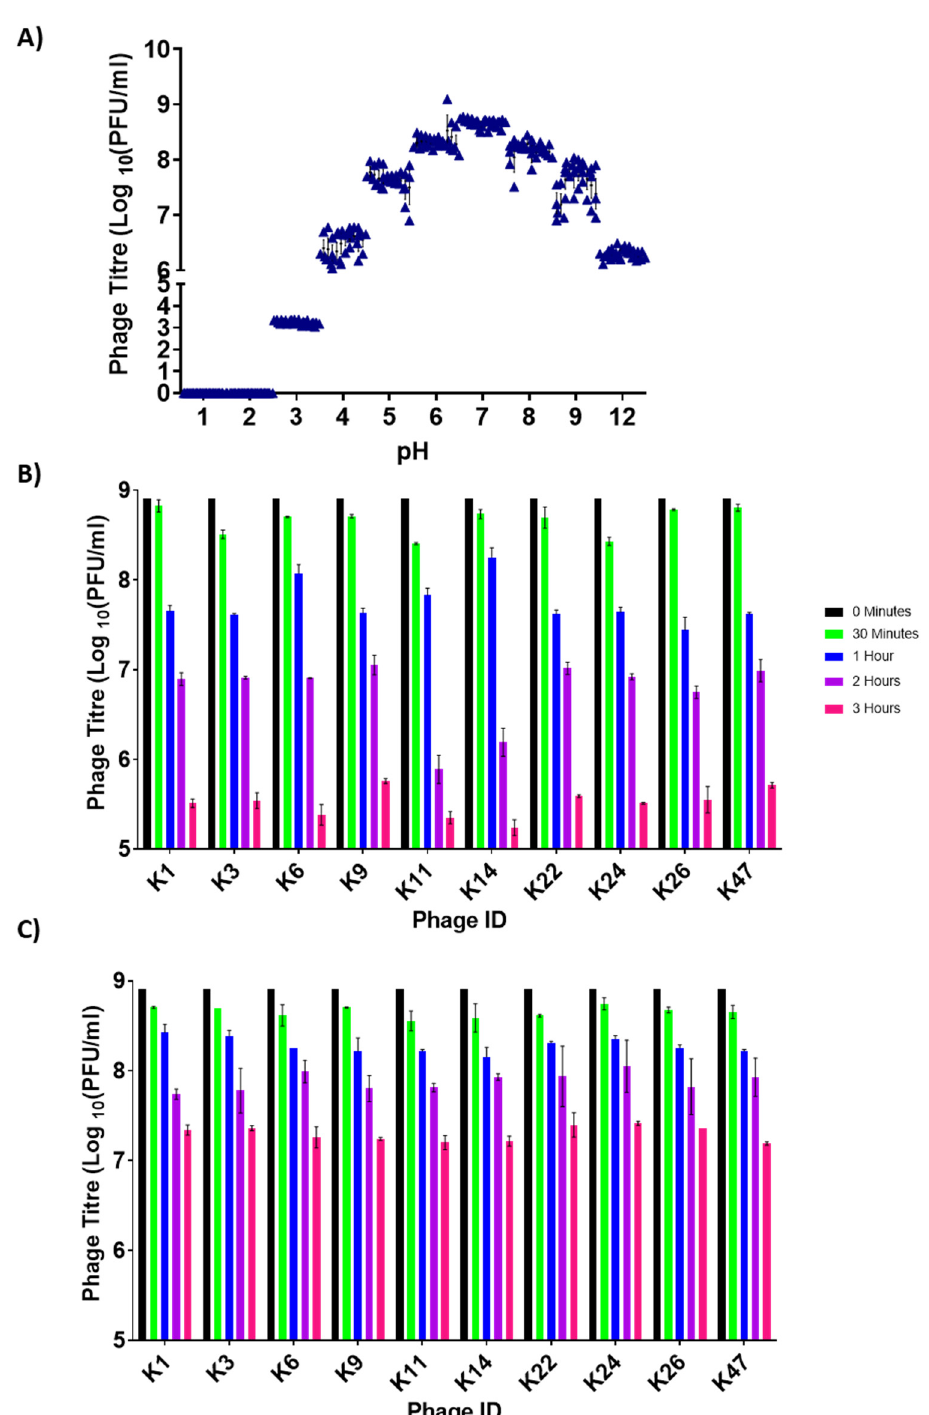
Figure 2. Phage stability in pH-adjusted TSB medium. ( A ) Cumulative stability of S . Enteritidis phages in TSB adjusted to pH values of 1, 2, 3, 4, 5, 6, 7, 8, 9, and 12 after 12 h of incubation at 37 °C. The black triangle indicates individual replicate values of phages on each bar graph. ( B ) Stability of individual S . Enteritidis phages in TSB at pH 3 for up to 3 h of incubation at 37 °C. Each bar indicates phage titres at specific times. ( C ) Stability of individual S . Enteritidis phages in TSB at pH 9 for up to 3 h of incubation at 37 °C. Each bar indicates phage titres at specific times. Error bars represent the standard error of the mean ( ± SE). Black bar: 0 min, green bar: 30 min, blue bar: 1 h, purple bar: 2 h, magenta bar: 3 h. All experiments were repeated twice and measured in